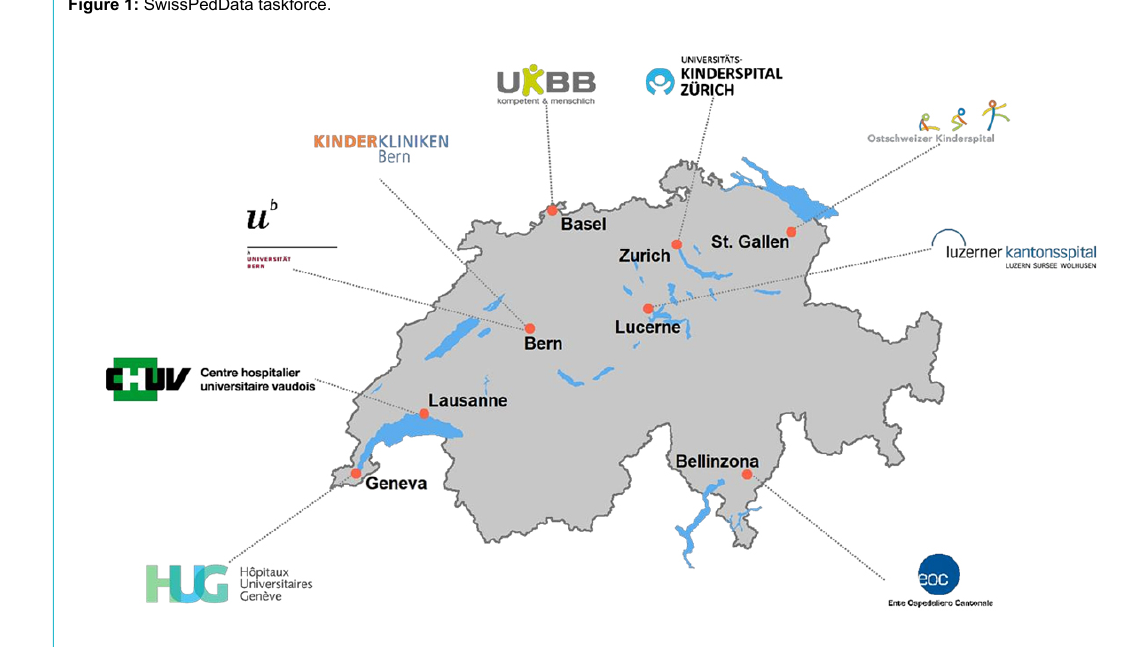
Figure 1: SwissPedData